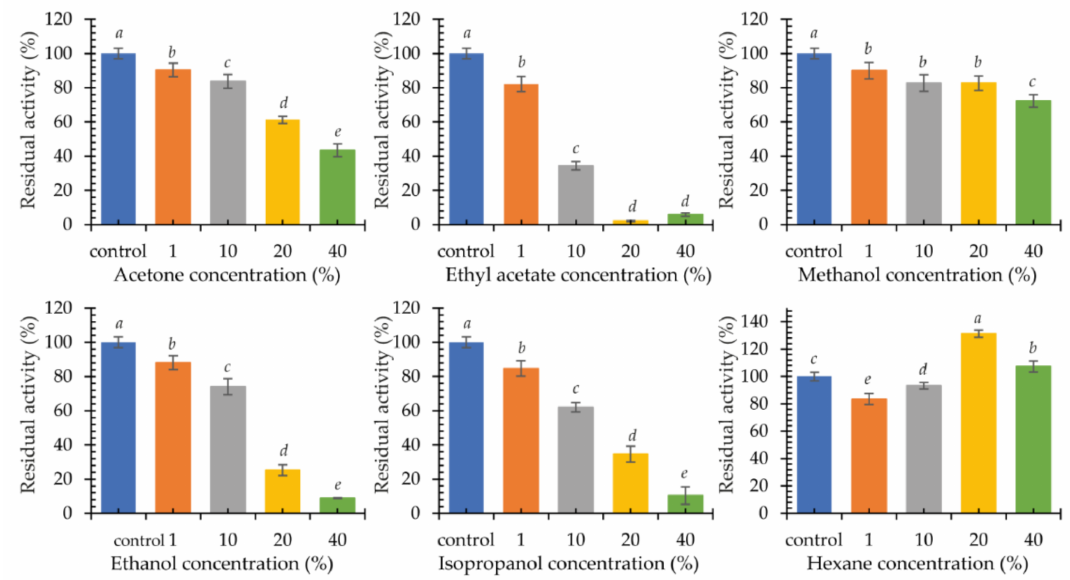
Figure 9. Stability of purified recombinant laccase KbLcc1 activity after 24-h pre-incubation with organic solvents at 1%, 10%, 20% and 40% ( v / v ) concentration; the data presented as the means ± SD from at least three independent experiments; the means that are marked with different letters ( a – e ) are significantly different ( p <